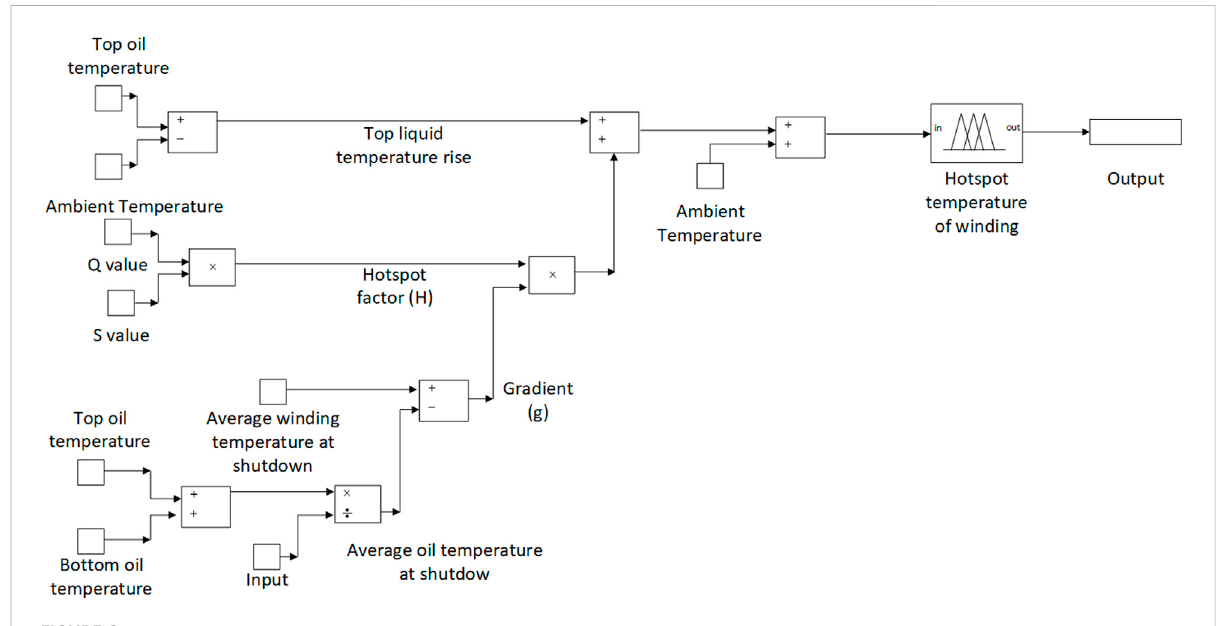
TABLE 4 Health index based on the hot spot temperature of winding. Parameters assessed Unit Data obtained from